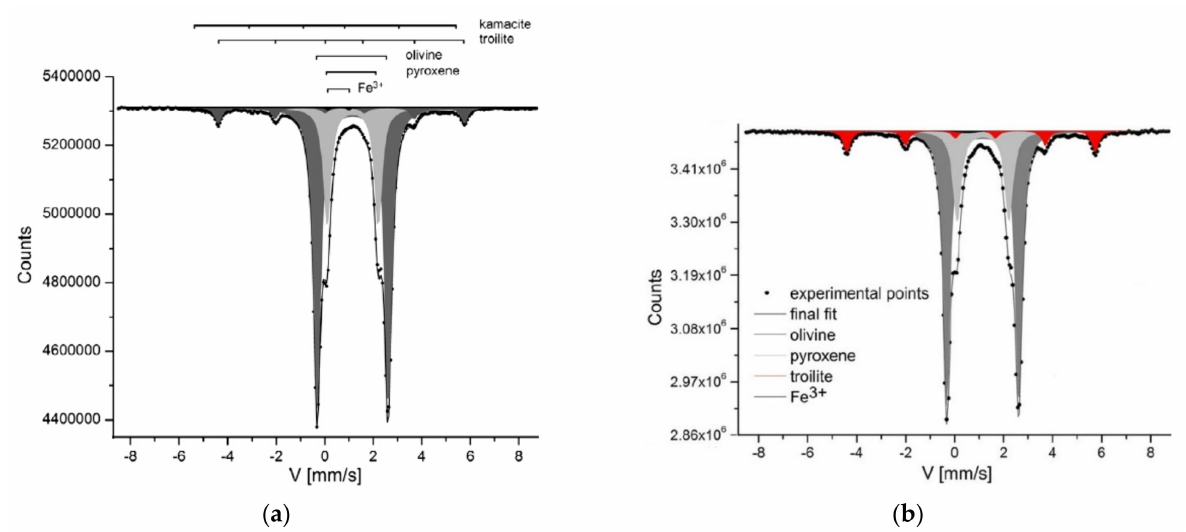
Figure 33. Room temperature Mössbauer spectra of equilibrated ordinary chondrites NWA 7733 LL5-6 [105] ( a ) and Kilabo LL6 [97] ( b ). Indicated components are the results of the fits. Adapted from References [97,105]. The spectrum of NWA 7733 LL5-6 was fitted using two magnetic sextets and three quadrupole doublets which were associated with: ( i ) kamacite ( δ = 0.01 mm/s, H eff = 335